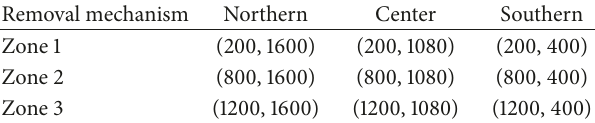
Table 1: Removal mechanism locations (𝑥,𝑦) (meter, meter).